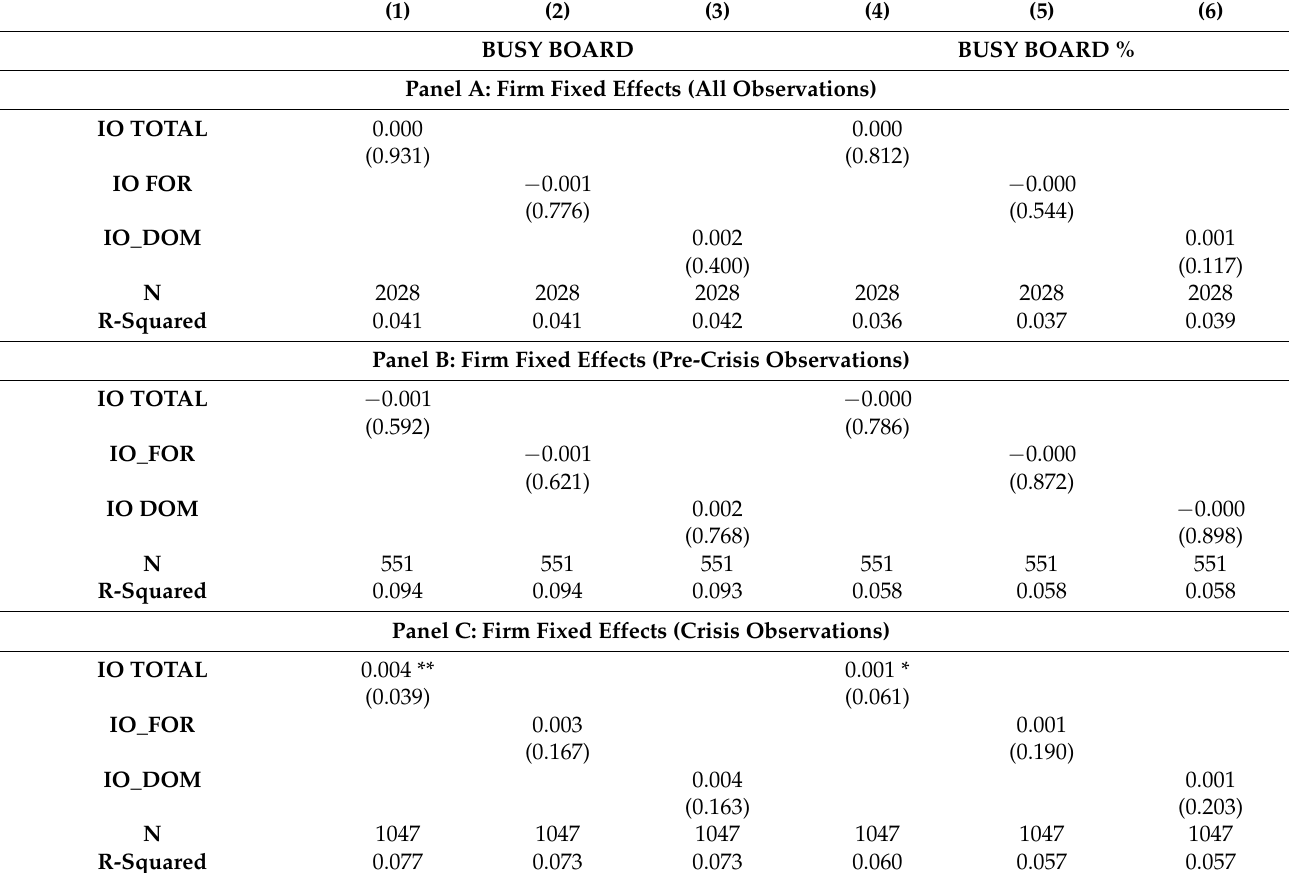
Table 5. Institutional ownership and board busyness.